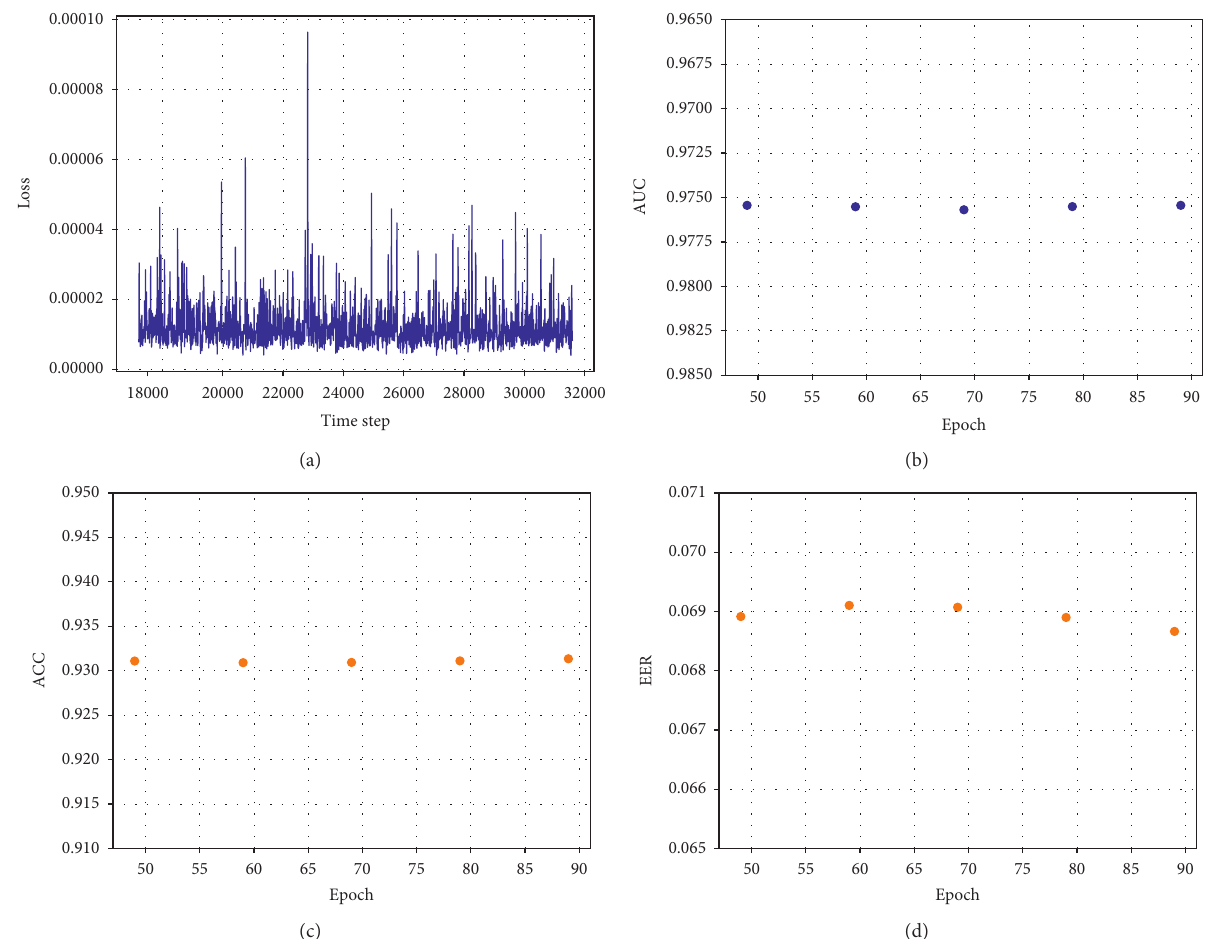
Figure 12: DTFA-Net training and evaluation results in Epoch49-89: (a) the loss fluctuations of model training in Epoch49-89; (b) the AUC results of the model in the test set in Epoch49-89; (c) the ACC results of the model in the test set in Epoch49-89; (d) the ERR results of the model in the test set in